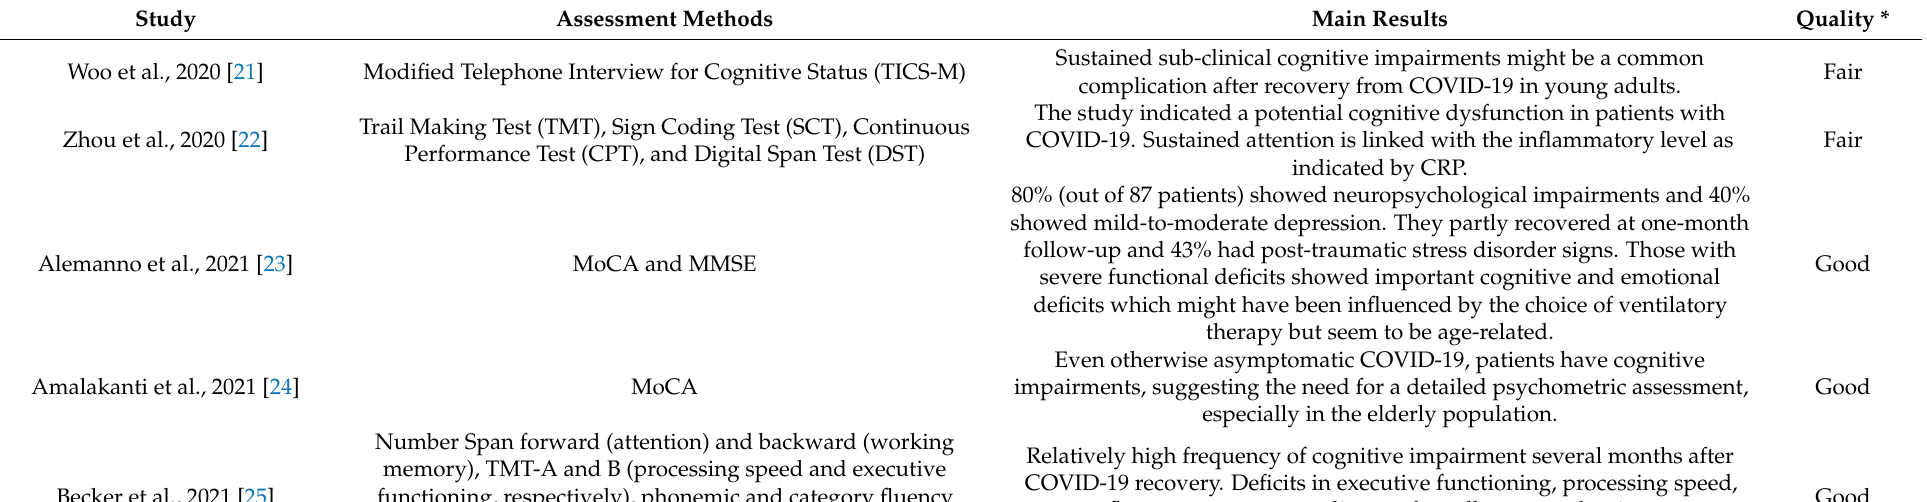
Table 2. Description of the tests used to assess the cognitive function and main results of the included